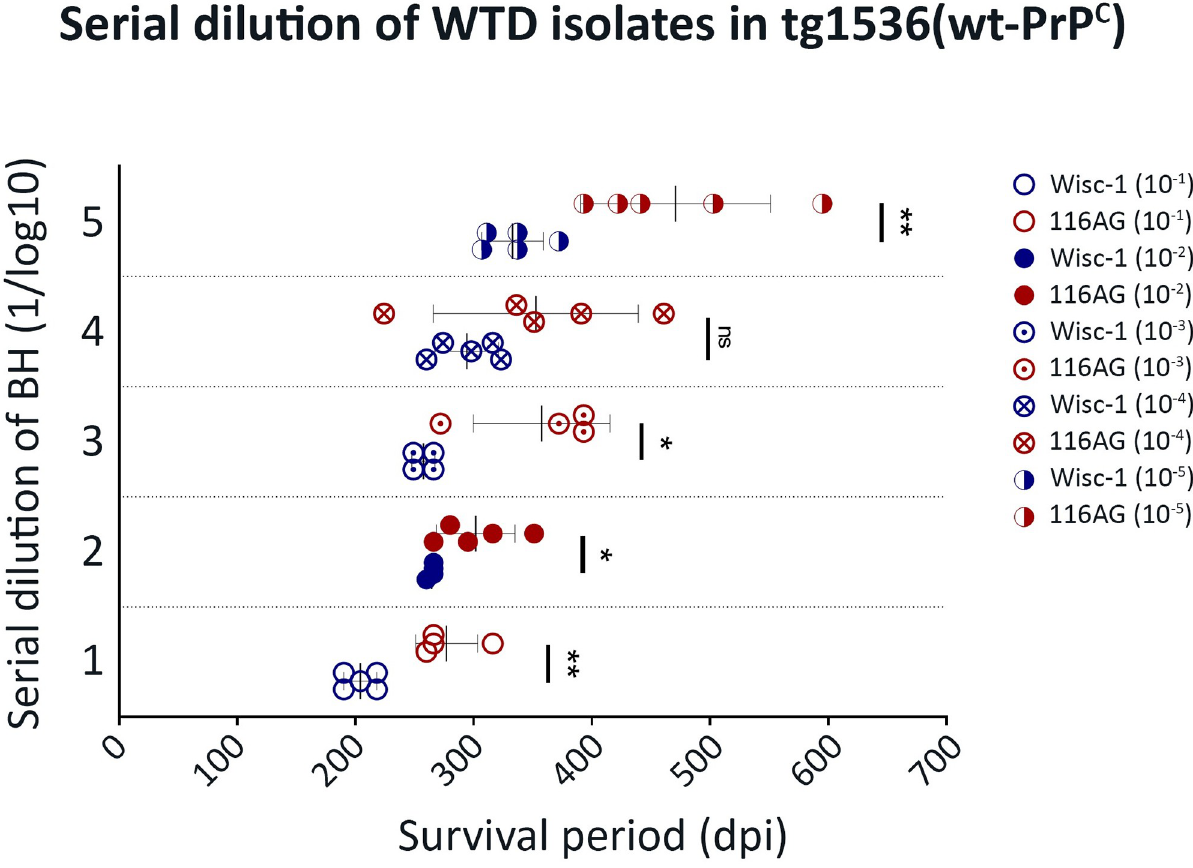
Fig 4. Inoculation of tg1536 mice with serial dilutions of Wisc-1 and 116AG. The graphs recapitulate the survival times of tg1536 +/+ mice intracerebrally inoculated with 20 ul of serial tenfold dilutions of Wisc-1 (blue) and 116AG (red) isolates. An unpaired student’s t-test was used to compare between the different groups ( � p < 0.05, �� p < 0.01, ns p >